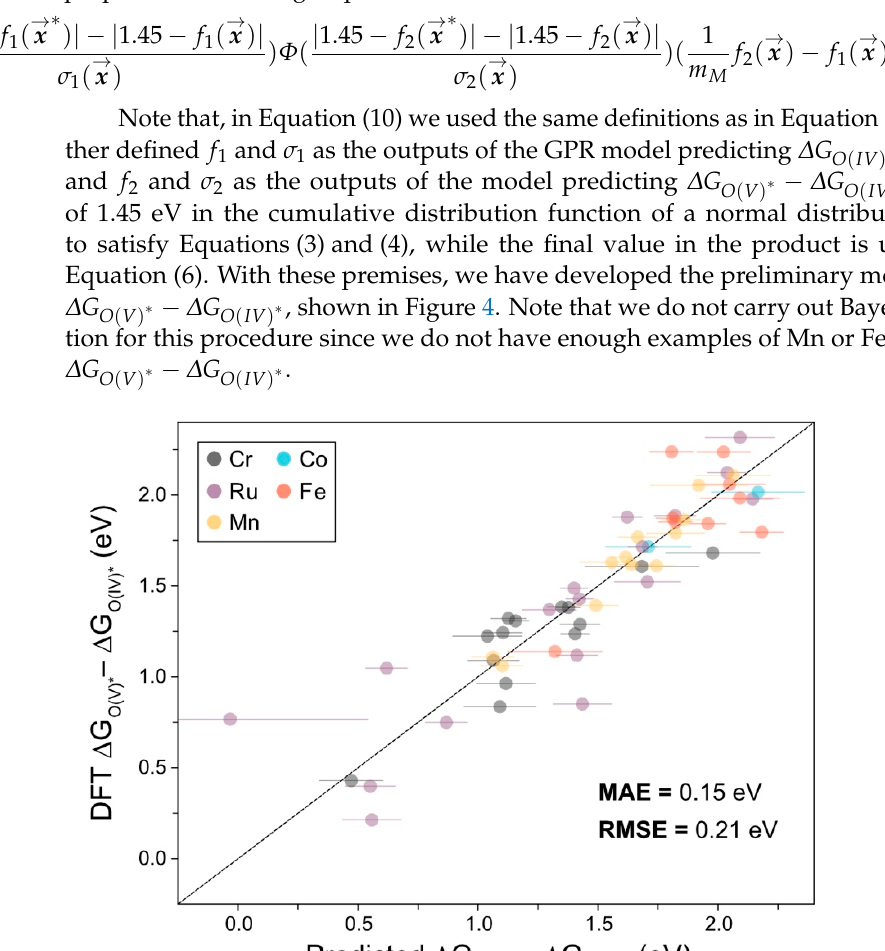
− ∆ G for a subset of catalysts O ( V ) ∗ O ( IV ) ∗